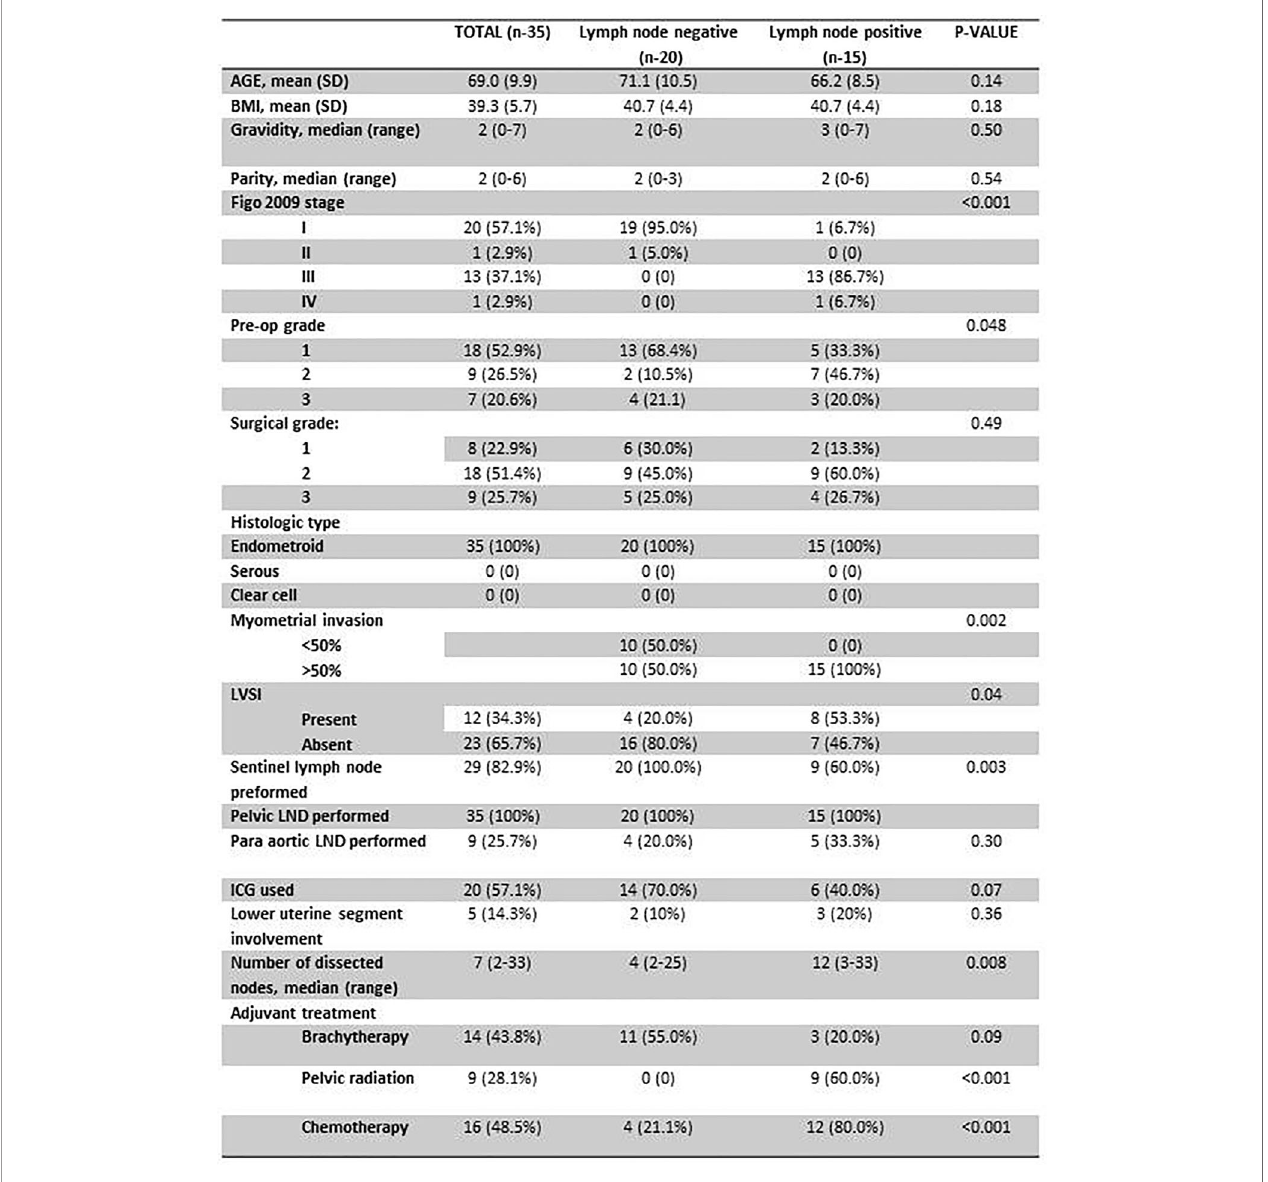
FIGURE 2 | Basic characteristics of the validation